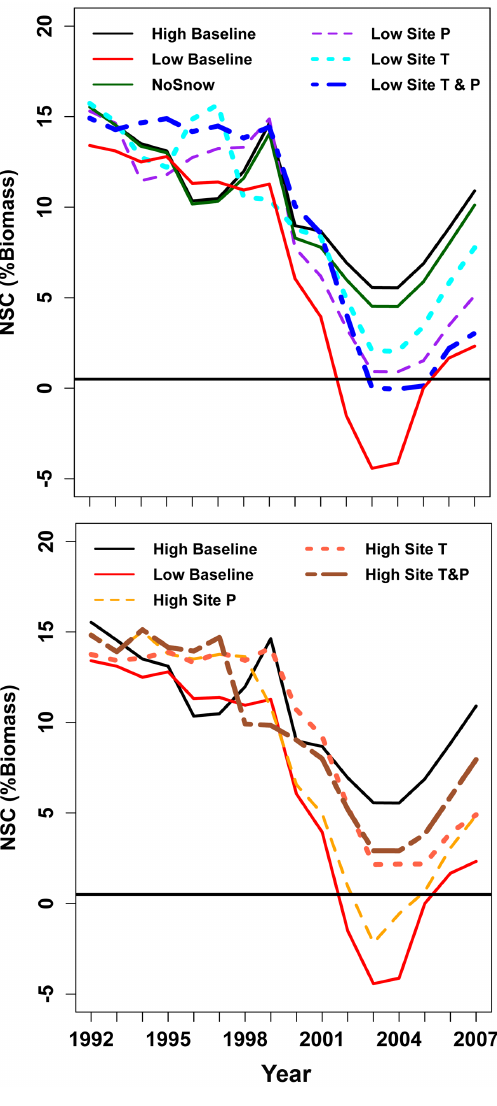
Figure 9. Trajectories of NSC through the 1992 – 2004 simula- tion period. Graphs of NSC trajectories are shown for both the pre- drought and drought years. NSC/NPP and MinL/AGC are set to 0.3 and 0.05 respectively and structural carbon estimates are initialized to be uniform across all 3 sites. Results are shown for the high site for 5 scenarios: baseline, all precipitation falls as rain (no snow), precipitation from low elevation site, temperature from low elevation site and both temperature and precipitation from the low elevation site. For the low elevation site 4 scenarios are shown: baseline, precipitation from high elevation site, temperature from high elevation site and both temperature and precipitation from the high elevation site.